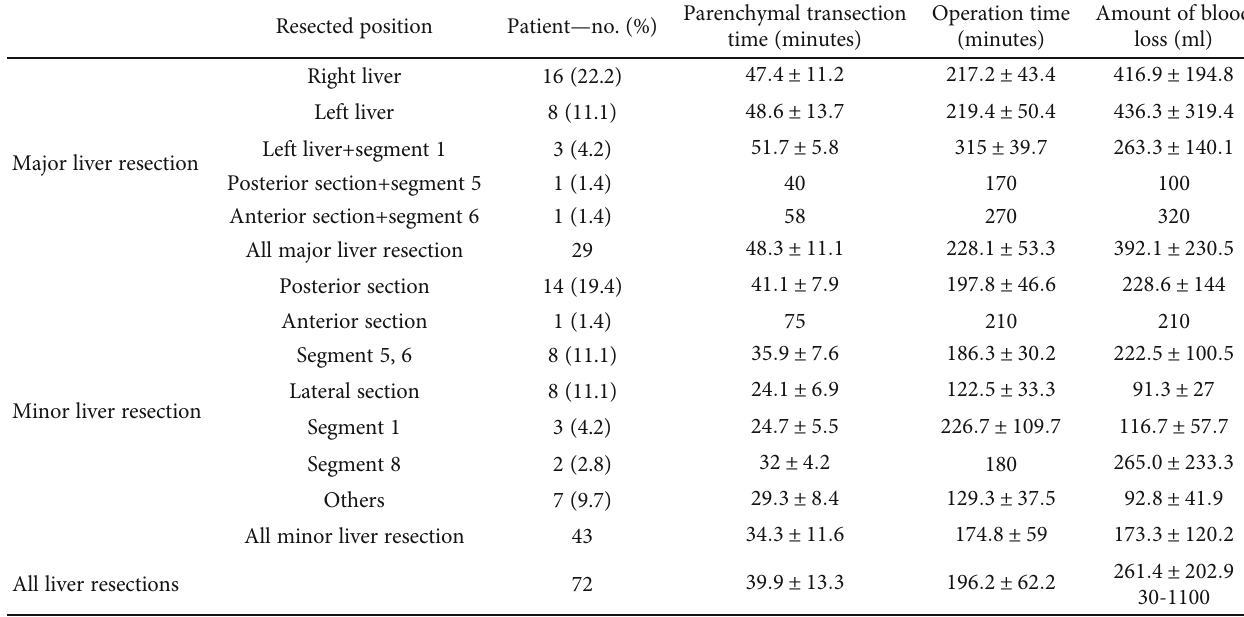
Table 3: Parenchymal transection, operation time, and the amount of blood loss during surgery. Resected position Patient — no. (%)